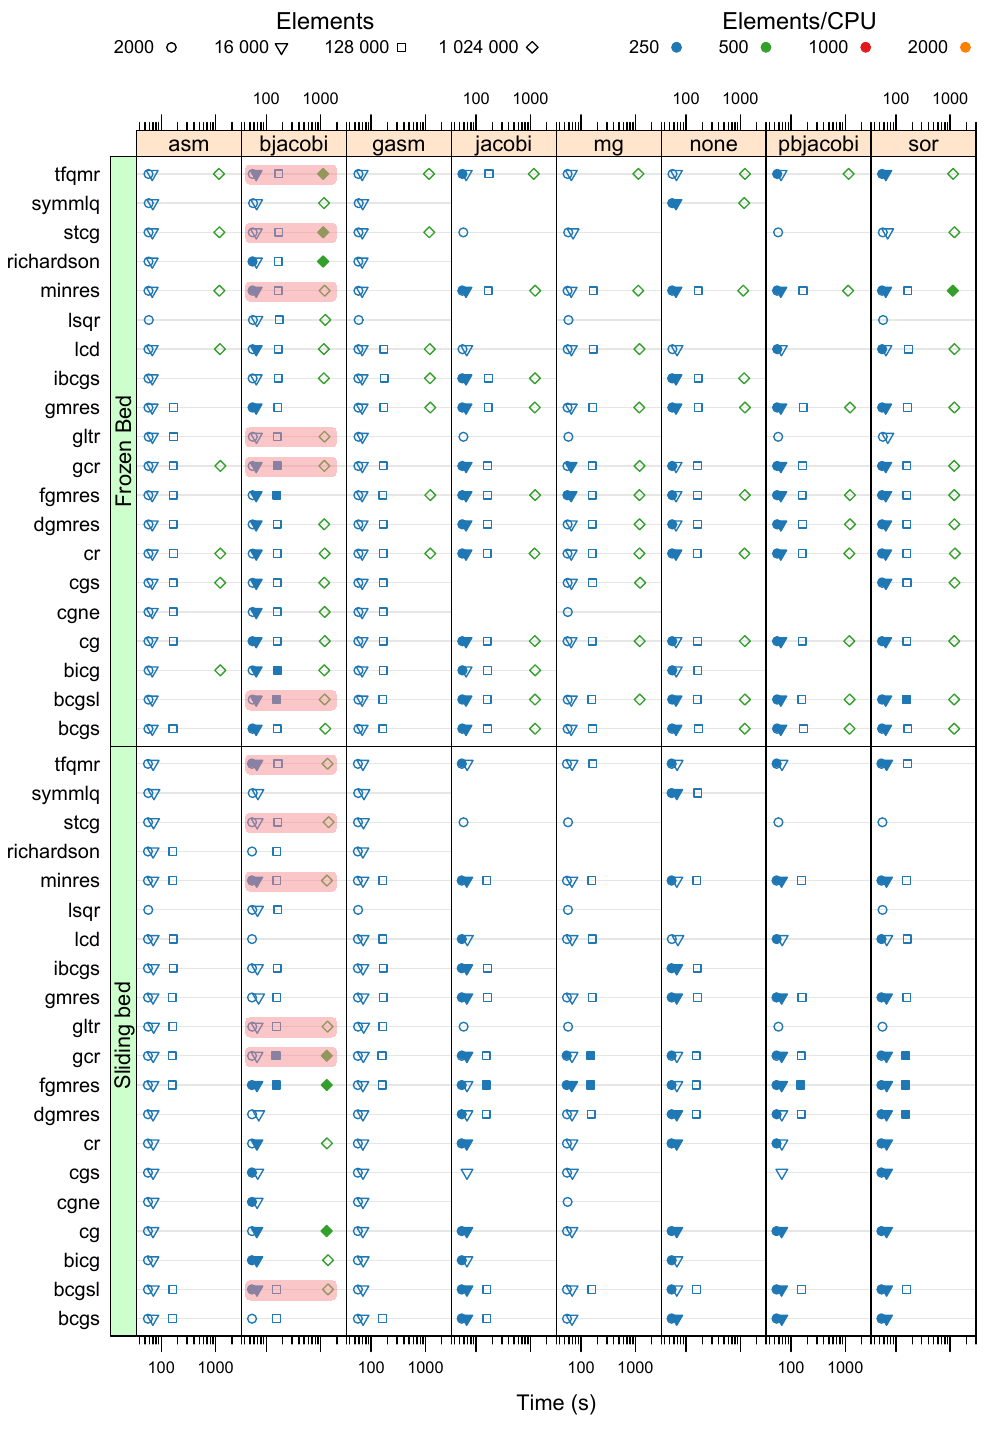
Figure 2. Horizontal velocity analysis: timing results for the fastest solvers (top 10%) tested on ISMIP-HOM Experiment F. The top (1%) timing results are distinguished using color-filled symbols. Both basal boundary conditions for Experiment F are shown: frozen bed (upper half) and sliding bed (lower half). Each solver is represented by the combination of a preconditioner (horizontal rows) and a Krylov subspace method (vertical columns) using PETSc abbreviations. Simulations are performed using four mesh sizes (denoted by the symbols in the legend) and four CPU cases (denoted by the colors in the legend). Only the fastest CPU case (i.e., color) is displayed. Red shaded boxes highlight solver combinations that rank among the fastest methods for all model sizes and both bed conditions (i.e., four symbols in the top and bottom